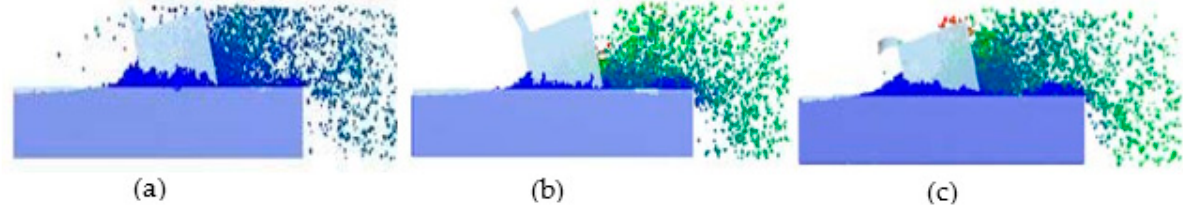
Figure 14. Simulation tests on soil-breaking blades. ( a ) Straight blades; ( b ) L-shaped blades; ( c ) Bent blades.